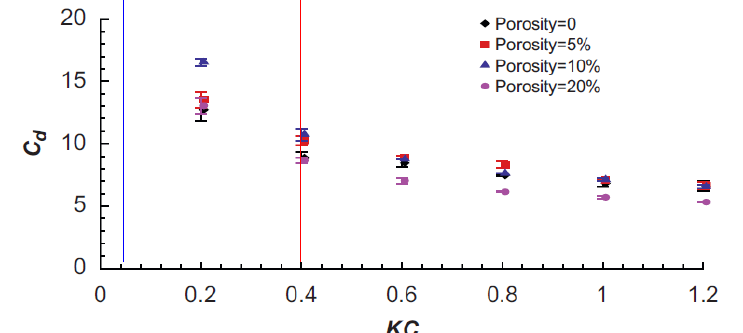
Figure 8. Vertical drag coefficient C d , hp for heave plates of different porosities (only 0-porosity relevant) with vertical lines for Keulegan–Carpenter (KC) values corresponding to LC 7 (blue) and LC 9 (red) of [39]. Adapted from ([32], p. 1012) with permission from Elsevier, 2018.